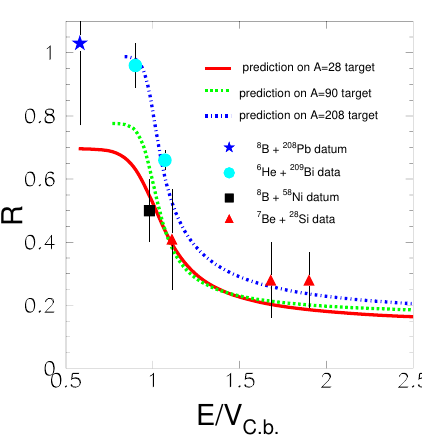
Figure 3. Ratio’s, R, direct to total reaction cross section. Lines correspond to predictions obtained earlier [12], from experimen- tal data of weakly bound neutron rich nuclei on various targets, appropriately reduced (red-solid: A = 28, green-dotted A = 90, blue-dotted-dashed A = 208). The experimental datum for 8 B + 208 Pb [14], is designated with the blue star. A previous datum 8 B + 58 Ni with a black box [20, 21], while previous data for 7 Be + 28 Si [17] are designated with the red filled arrows, and 6 He + 209 Bi data with cyan filled circles